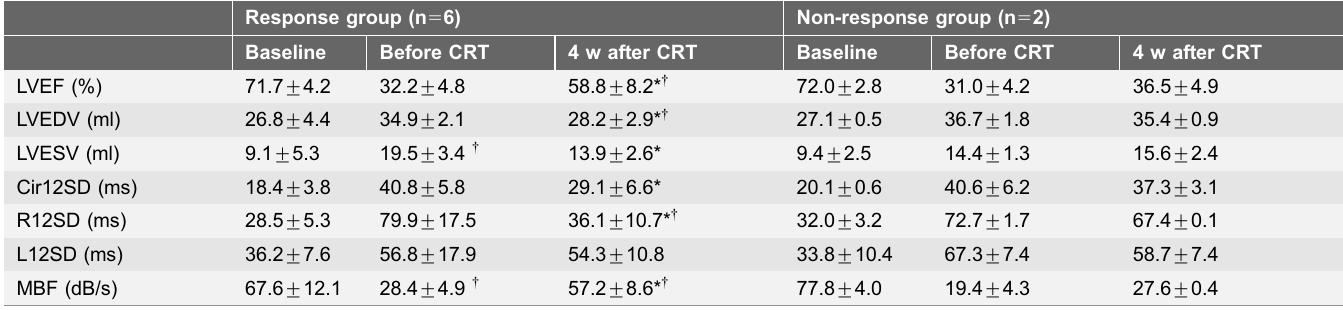
Table 2. The echocardiographic parameters between responders and